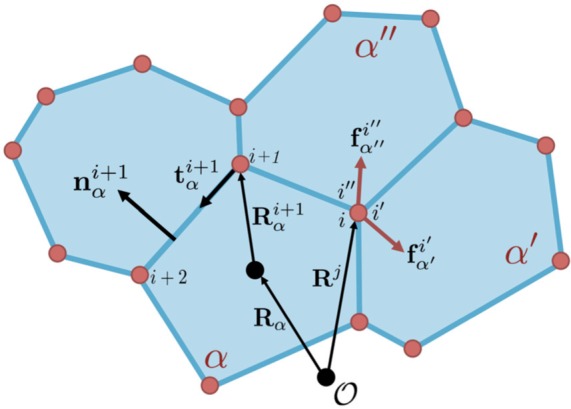
Representation of disordered cell geometry. Cell \documentclass[12pt]{minimal}
\usepackage{amsmath}
\usepackage{wasysym} 
\usepackage{amsfonts} 
\usepackage{amssymb} 
\usepackage{amsbsy}
\usepackage{upgreek}
\usepackage{mathrsfs}
\setlength{\oddsidemargin}{-69pt}
\begin{document}
}{}$\alpha$\end{document} has its centroid at \documentclass[12pt]{minimal}
\usepackage{amsmath}
\usepackage{wasysym} 
\usepackage{amsfonts} 
\usepackage{amssymb} 
\usepackage{amsbsy}
\usepackage{upgreek}
\usepackage{mathrsfs}
\setlength{\oddsidemargin}{-69pt}
\begin{document}
}{}$\mathbf{R}_{\alpha}$\end{document} relative to a fixed origin, \documentclass[12pt]{minimal}
\usepackage{amsmath}
\usepackage{wasysym} 
\usepackage{amsfonts} 
\usepackage{amssymb} 
\usepackage{amsbsy}
\usepackage{upgreek}
\usepackage{mathrsfs}
\setlength{\oddsidemargin}{-69pt}
\begin{document}
}{}$\mathscr{O}$\end{document}. The position of vertex \documentclass[12pt]{minimal}
\usepackage{amsmath}
\usepackage{wasysym} 
\usepackage{amsfonts} 
\usepackage{amssymb} 
\usepackage{amsbsy}
\usepackage{upgreek}
\usepackage{mathrsfs}
\setlength{\oddsidemargin}{-69pt}
\begin{document}
}{}$i$\end{document} of cell \documentclass[12pt]{minimal}
\usepackage{amsmath}
\usepackage{wasysym} 
\usepackage{amsfonts} 
\usepackage{amssymb} 
\usepackage{amsbsy}
\usepackage{upgreek}
\usepackage{mathrsfs}
\setlength{\oddsidemargin}{-69pt}
\begin{document}
}{}$\alpha$\end{document} is given equivalently via \documentclass[12pt]{minimal}
\usepackage{amsmath}
\usepackage{wasysym} 
\usepackage{amsfonts} 
\usepackage{amssymb} 
\usepackage{amsbsy}
\usepackage{upgreek}
\usepackage{mathrsfs}
\setlength{\oddsidemargin}{-69pt}
\begin{document}
}{}$\mathbf{R}^{i}_{\alpha}$\end{document}, relative to the centroid, or \documentclass[12pt]{minimal}
\usepackage{amsmath}
\usepackage{wasysym} 
\usepackage{amsfonts} 
\usepackage{amssymb} 
\usepackage{amsbsy}
\usepackage{upgreek}
\usepackage{mathrsfs}
\setlength{\oddsidemargin}{-69pt}
\begin{document}
}{}$\mathbf{R}^{j}$\end{document}, relative to \documentclass[12pt]{minimal}
\usepackage{amsmath}
\usepackage{wasysym} 
\usepackage{amsfonts} 
\usepackage{amssymb} 
\usepackage{amsbsy}
\usepackage{upgreek}
\usepackage{mathrsfs}
\setlength{\oddsidemargin}{-69pt}
\begin{document}
}{}$\mathscr{O}$\end{document}. For a vertex (trijunction) at \documentclass[12pt]{minimal}
\usepackage{amsmath}
\usepackage{wasysym} 
\usepackage{amsfonts} 
\usepackage{amssymb} 
\usepackage{amsbsy}
\usepackage{upgreek}
\usepackage{mathrsfs}
\setlength{\oddsidemargin}{-69pt}
\begin{document}
}{}$\mathbf{R}^{j}$\end{document}, there exist three vectors, \documentclass[12pt]{minimal}
\usepackage{amsmath}
\usepackage{wasysym} 
\usepackage{amsfonts} 
\usepackage{amssymb} 
\usepackage{amsbsy}
\usepackage{upgreek}
\usepackage{mathrsfs}
\setlength{\oddsidemargin}{-69pt}
\begin{document}
}{}$\mathbf{R}^{i}_{\alpha}, \mathbf{R}^{i^{\prime}}_{\alpha^{\prime}}, \mathbf{R}^{i^{\prime\prime}}_{\alpha^{\prime\prime}}$\end{document} for cells, \documentclass[12pt]{minimal}
\usepackage{amsmath}
\usepackage{wasysym} 
\usepackage{amsfonts} 
\usepackage{amssymb} 
\usepackage{amsbsy}
\usepackage{upgreek}
\usepackage{mathrsfs}
\setlength{\oddsidemargin}{-69pt}
\begin{document}
}{}$\alpha, \alpha^{\prime}, \alpha^{\prime\prime}$\end{document}, pointing to the same vertex. Cell properties, such as area and tangents along edges, are defined relative to the cell centroid. (Colour in online.)